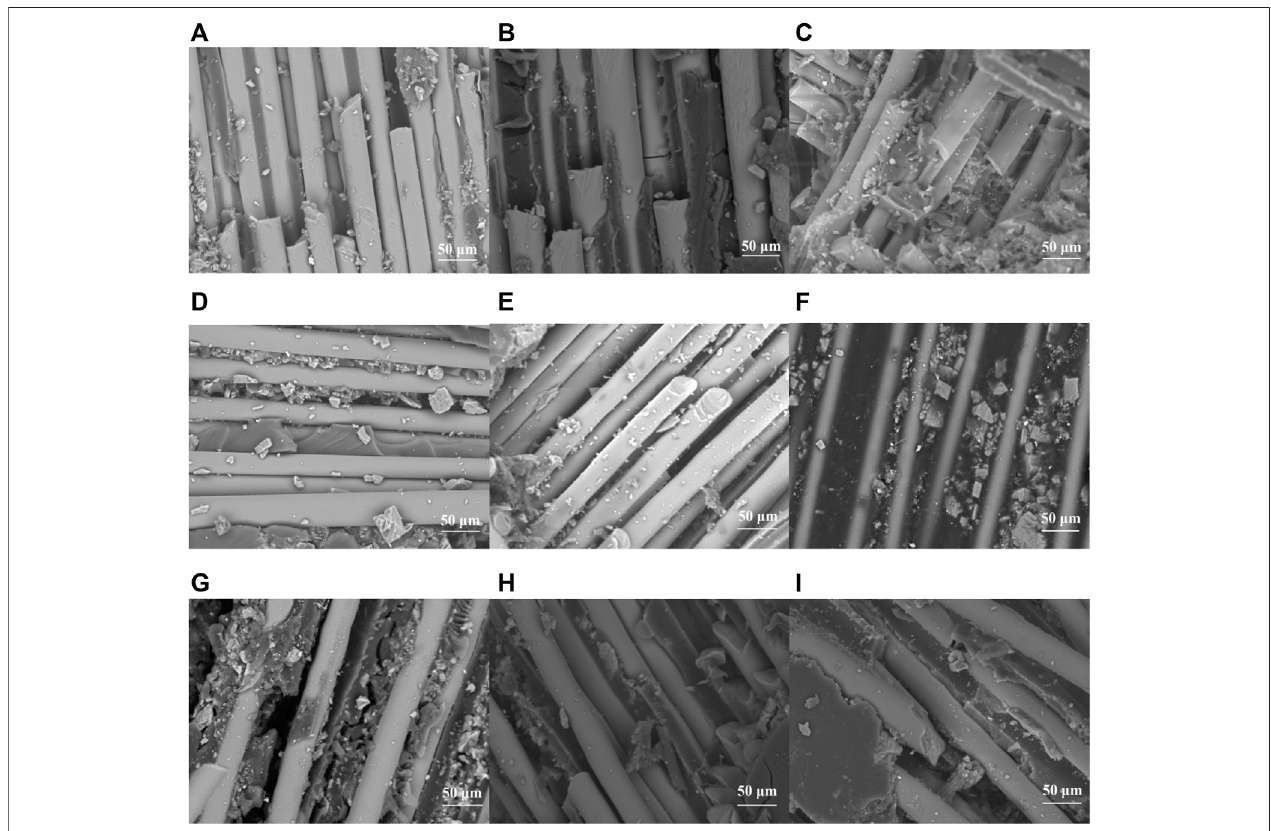
FIGURE 8 | Scanning electron micrographs of the UP GFRP specimens: (A) unexposed, (B) exposed to deionized water for 30 days, (C) exposed to deionized water for 360 days, (D) exposed to salt water for 30 days, (E) exposed to salt water for 360 days, (F) exposed to salt fog for 30 days, (G) exposed to salt fog for 360 days, (H) exposed to combined hygrothermal cycling without sustained loading for 30 days, and (I) exposed to combined hygrothermal cycling without sustained loading for 360